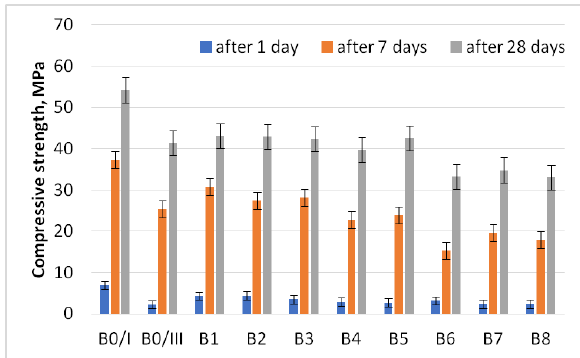
Figure 4: The influence of cement type on compressive strength of self-compacting